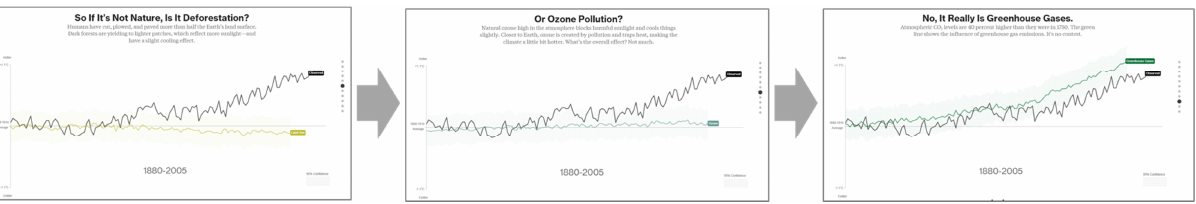
Figure 3: Roston, E. & Migliozzi, B. (2015). What’s Really Warming the World by Bloomberg. URL: